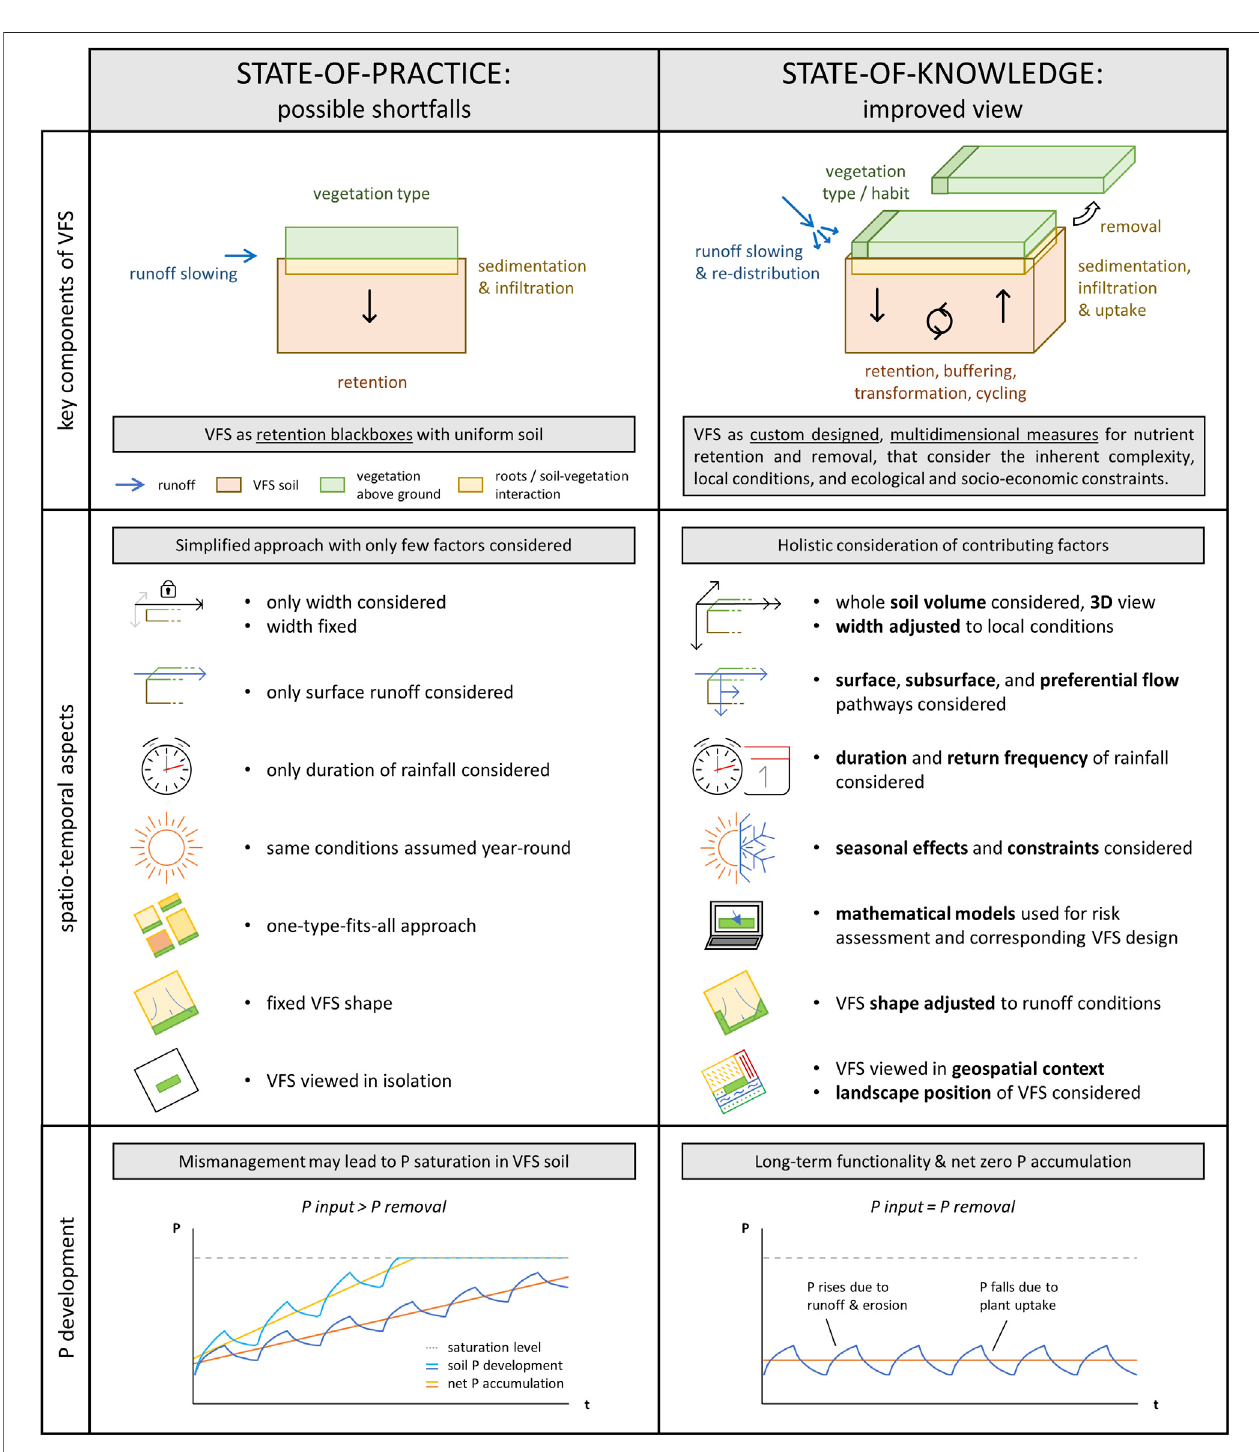
FIGURE 1 | Schematic overview of possible shortfalls during VFS design and research (left column) and suggested improvements (right column), regarding the conceptualization (top panel), considered aspects (mid panel), and P development in the VFS soil (bottom panel; lighter colours depict P development without harvesting). Legends apply for both